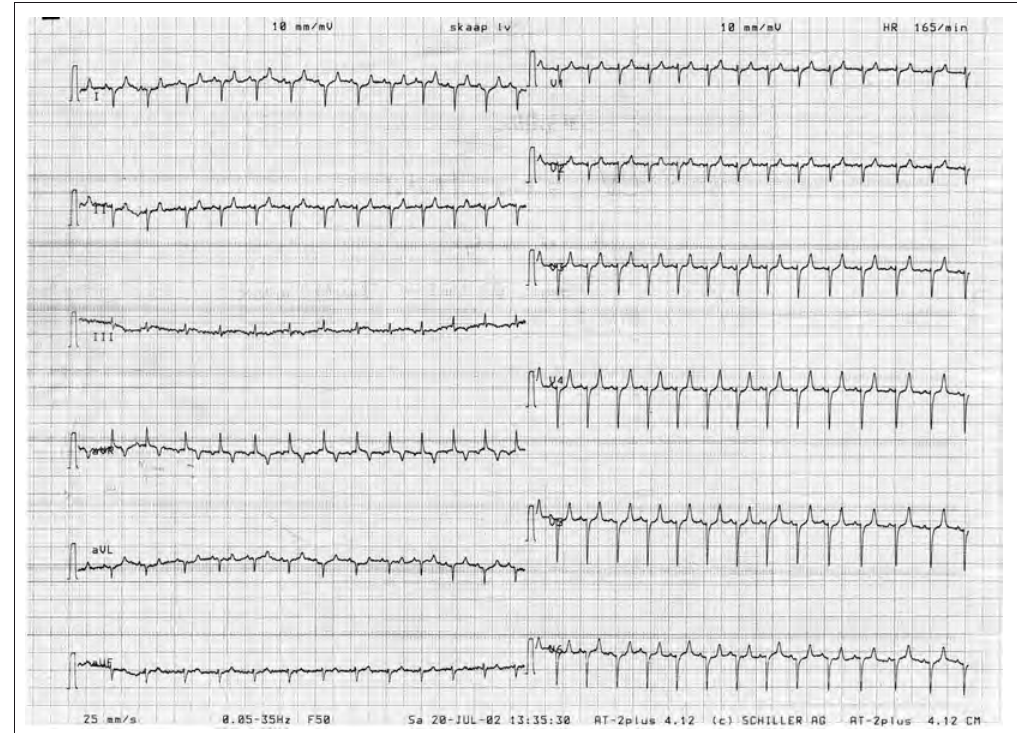
FIG. 1 The normal 12-lead electrocardiogram, before the induction of